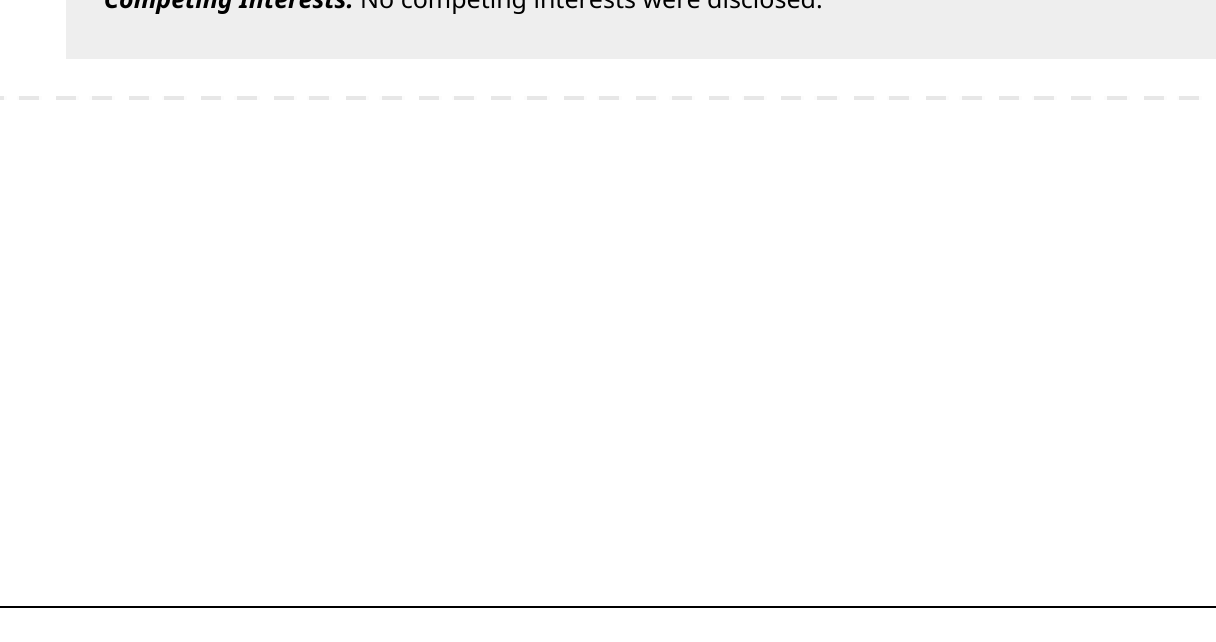
RE: Table 3 shows that S protein D614G and ORF1b nsp12 P323L mutations have the top 2 highest frequency. They are found in more than 90% of 30229 SARS-CoV-2 genome sequences, which are from the early batch of SARS-CoV-2 genome data. A similar finding has been reported by S. Ilmjärv et al., “Concurrent mutations in RNA-dependent RNA polymerase and spike protein emerged as the epidemiologically most successful SARS-CoV- 2 variant,” Sci. Rep., vol. 11, no. 1, pp. 1–13, Jul. 2021. “The combination of both mutations may enhance viral fitness based on epidemiological